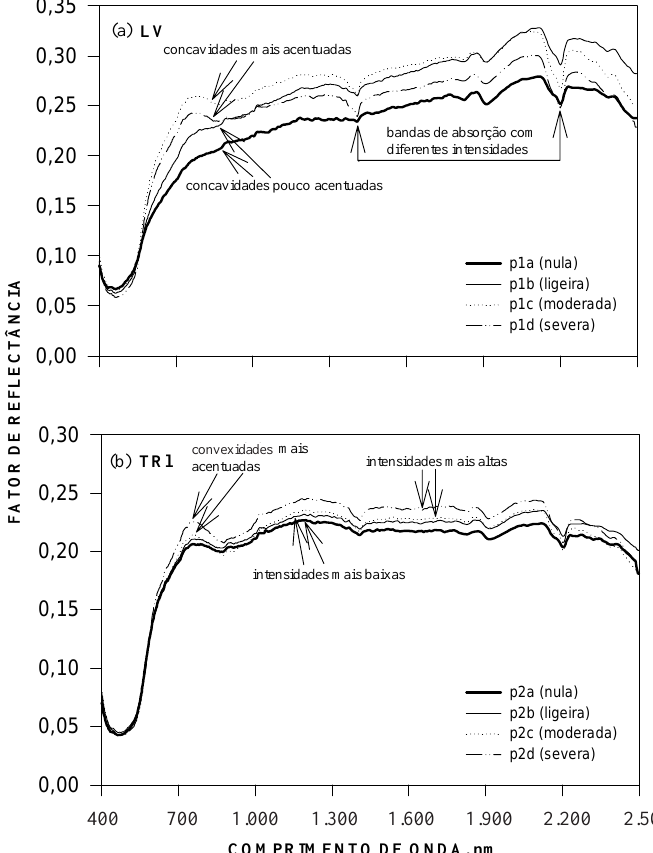
Figura 2. Dados espectrais obtidos com sensor terrestre do Latossolo Vermelho-Amarelo LV (a) e Terra Roxa Estruturada Latossólica TR1 (b) designados por diferentes níveis de erosão.